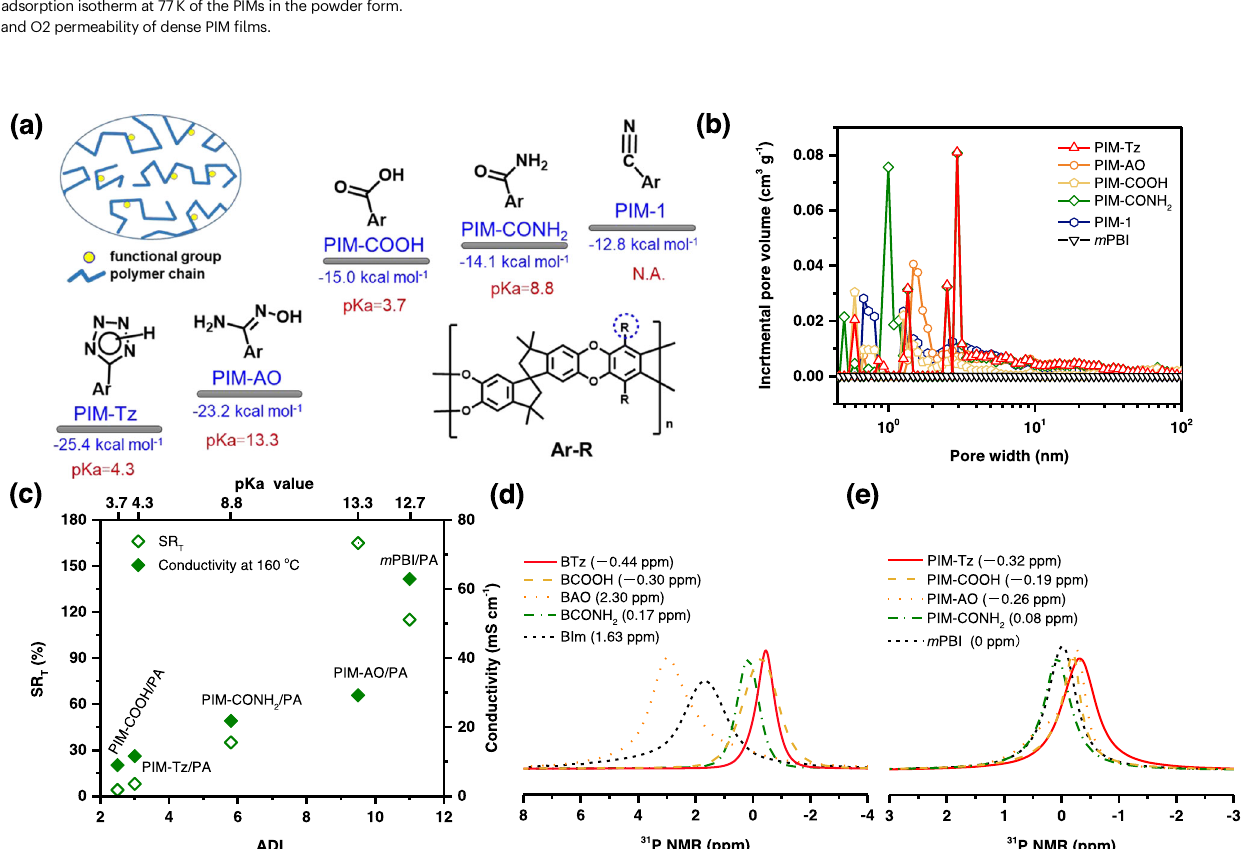
temperature and proton conductivity at 160°C. Solid-state 31 P NMR spectra of PA- doped samples: d functional benzene monomers doped with 1 equivalent pure PA and ( e ) polymer powders saturated with pure PA. Chemical shifts are presented in parentheses, externally referenced to (NH 4 ) 2 HPO 4